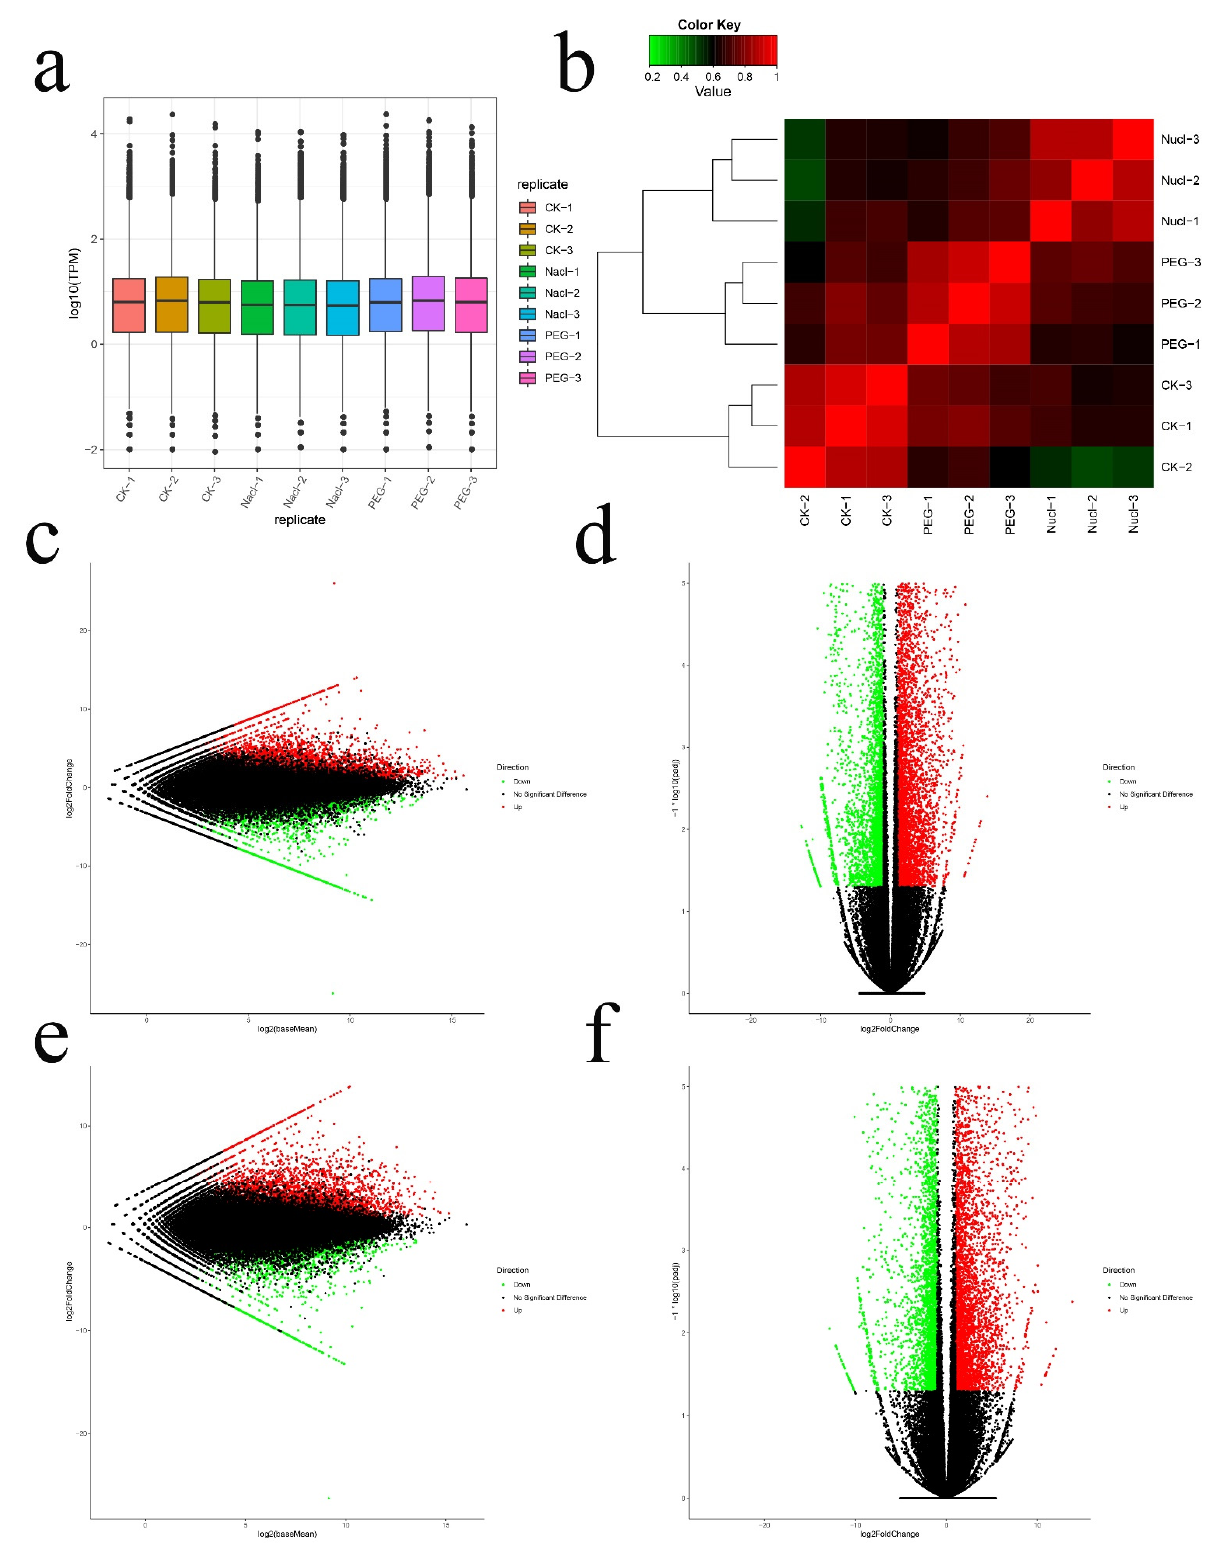
Figure 2. ( a ) The transcript per million (TPM) box plots. ( b ) Clustering analysis diagram between samples. ( c ) CK_VS_NaCl differentially expressed genes (DEGs) M-versus-A (MA) plot. ( d ) CK_VS_NaCl DEGs volcanic plot. ( e ) CK_VS_PEG DEGs MA plot. ( f ) CK_VS_PEG DEGs volcanic